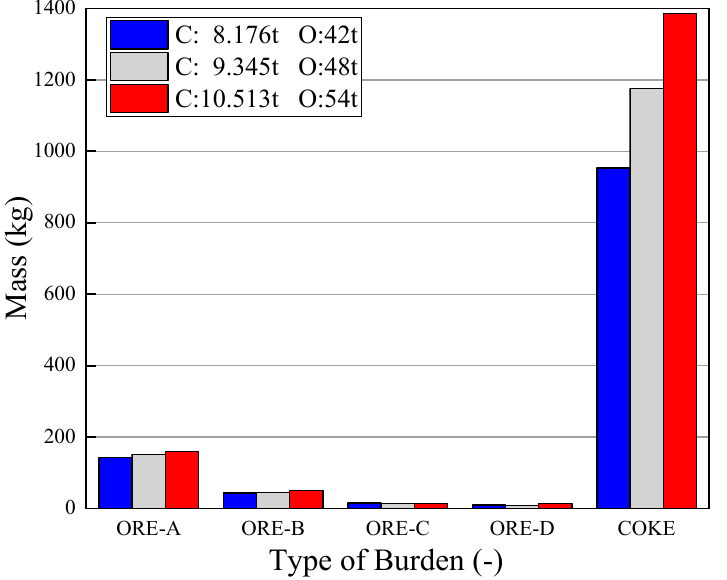
Figure 14. Burden distribution in the sampling area under different ore and coke batch